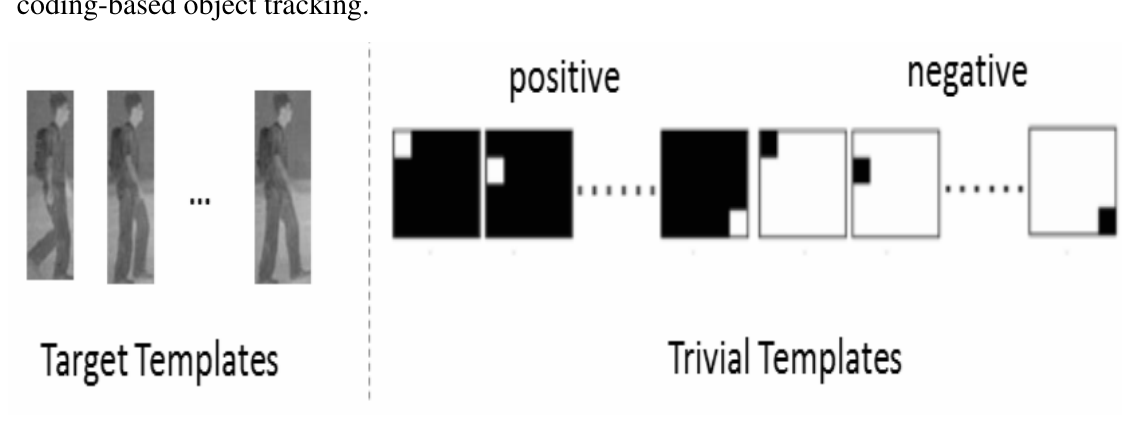
Figure 1. Decomposition of a dictionary into target and trivial templates in sparse coding-based object